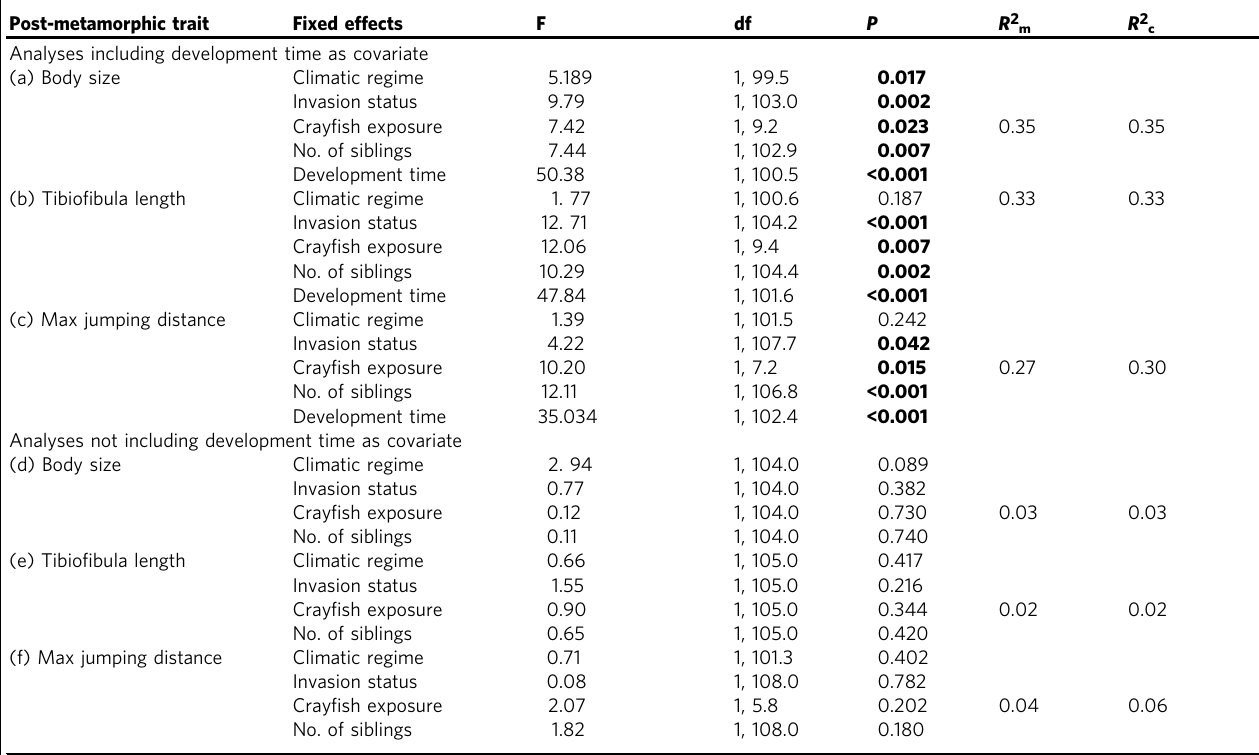
Table 2 Effect of treatment, invasion status, climatic regime and number of siblings on post-metamorphic traits of Italian agile frogs: results of linear mixed models (two-sided F tests without multiple test corrections) including development time as fi xed factor in the model (a – c) and results excluding development time from the model (d – f). Post-metamorphic trait Fixed